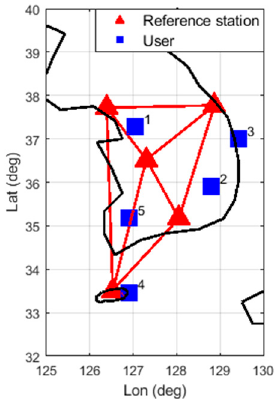
Figure 11. Reference station and user (real data). Table 2. Reference station and user information. Baseline length is listed for auxiliary stations.